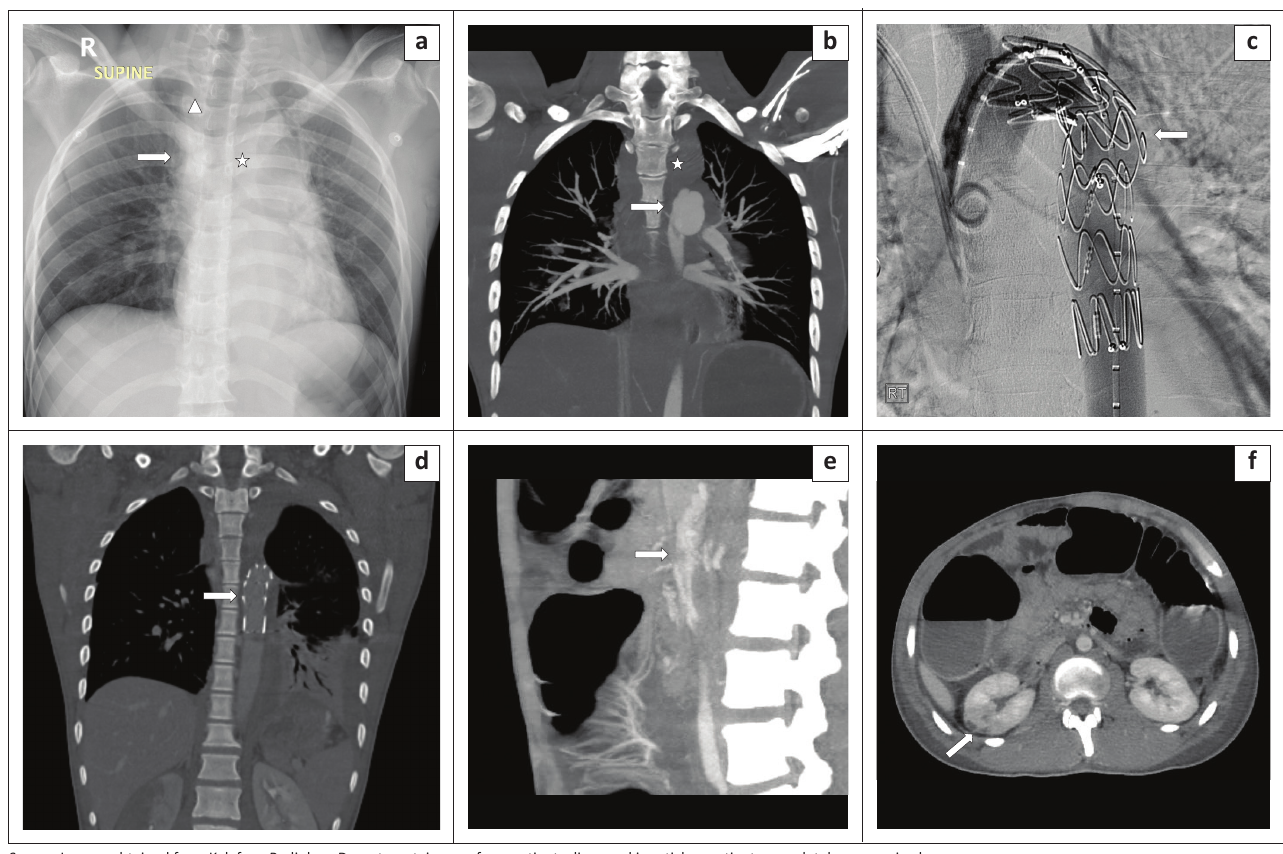
Source : Images obtained from Kalafong Radiology Department, images from patients discussed in article – patients completely anonymised FIGURE 2: (a) Chest radiography in a 23-year-old male involved in a pedestrian vehicle accident indicates a widened mediastinum (arrow), loss of the aortic knuckle (star), retro-cardiac double density and a widened right paraspinal line (triangle). (b) Coronal computed tomography angiography image with a type 2 aortic injury, complicated by thrombus formation (arrow). Also note the large mediastinal haematoma (star). (c) Sagittal digital subtraction angiogram after endovascular aneurysm repair with the stent in place (arrow). (d) Follow-up computed tomography angiography post stenting. (e) Sagittal computed tomography angiography abdomen demonstrating subtle thrombus within the coeliac artery (arrow). (f) Segmental infarction revealed within the right kidney